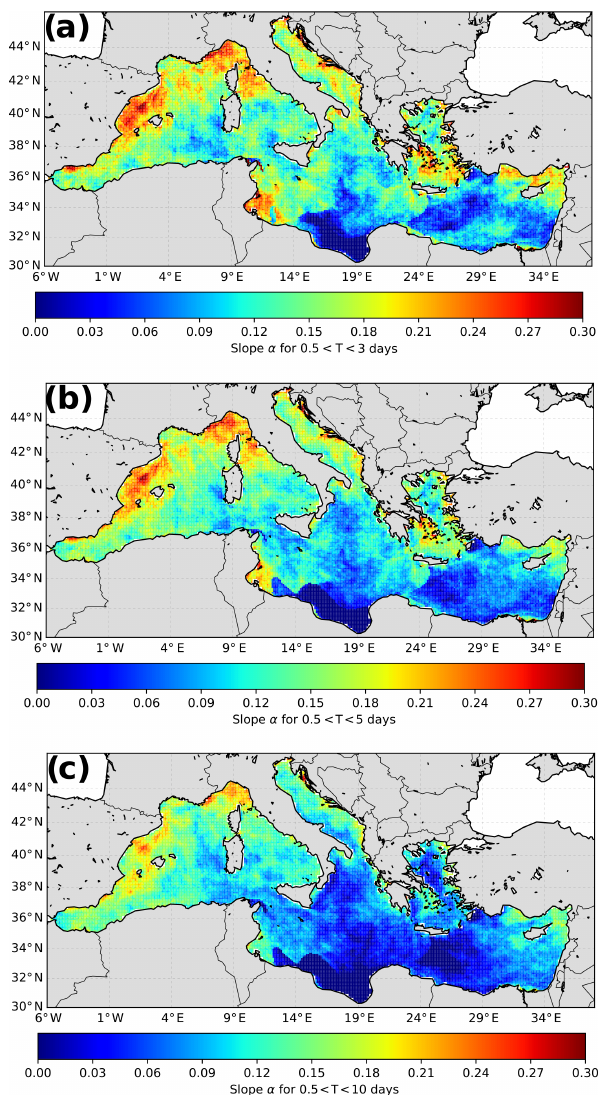
Figure 12. Spatial distribution of the exponent α for the whole of the Mediterranean